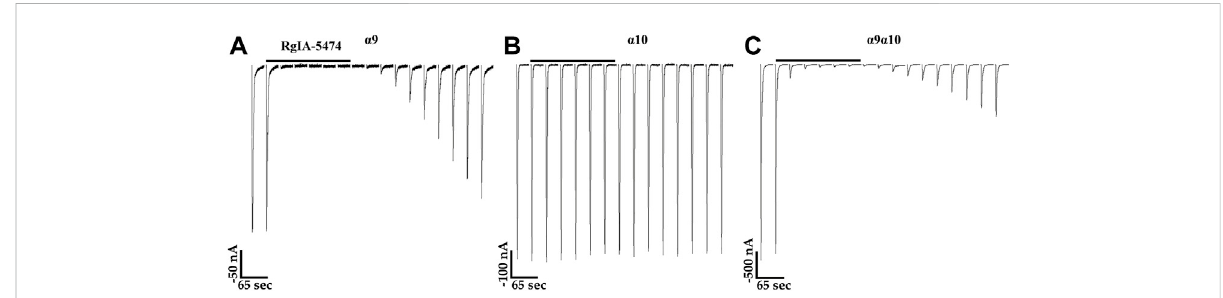
FIGURE 8 Currentsevokedbyacetylcholine (ACh) fromoocytesexpressing human α 9or α 9 α 10nAChRsare inhibited by α -Ctx RgIA-5474, but those from oocytes expressing α 10 nAChRs are not. (A) Traces showing inhibition of ACh-evoked (100 μ M) currents by RgIA-5474 from an oocyte expressing α 9nAChRs.Theresponsesinthepresenceofthepeptidewere1.0±0.4%(n=5)ofcontrolvalues. (B) Tracesfromanoocyteexpressing α 10nAChRs showinglackofinhibitionbyRgIA-5474onACh-evoked(1 mM)currents.Theresponsesinthepresenceofthepeptidewere100±3%(n=5)of control values. (C) Traces showing inhibition of ACh-evoked (100 μ M) currents by RgIA-5474 from an oocyte expressing α 9 α 10 nAChRs. The responses in the presence of the peptide were 3 ± 2% (n = 5) of control values. The horizontal bars above the current traces in (A – C) indicate perfusion with saline containing RgIA-5474 (50 nM). Current traces are shown with the 30 s interpulse intervals reduced to 5 s for brevity. The “ ± ” indicates SD and “ n ” indicates the number of oocytes obtained from three donors. Oocytes in (A) were preincubated in saline containing choline (5 mM) and those in (B) with STR (20 μ M) for 3